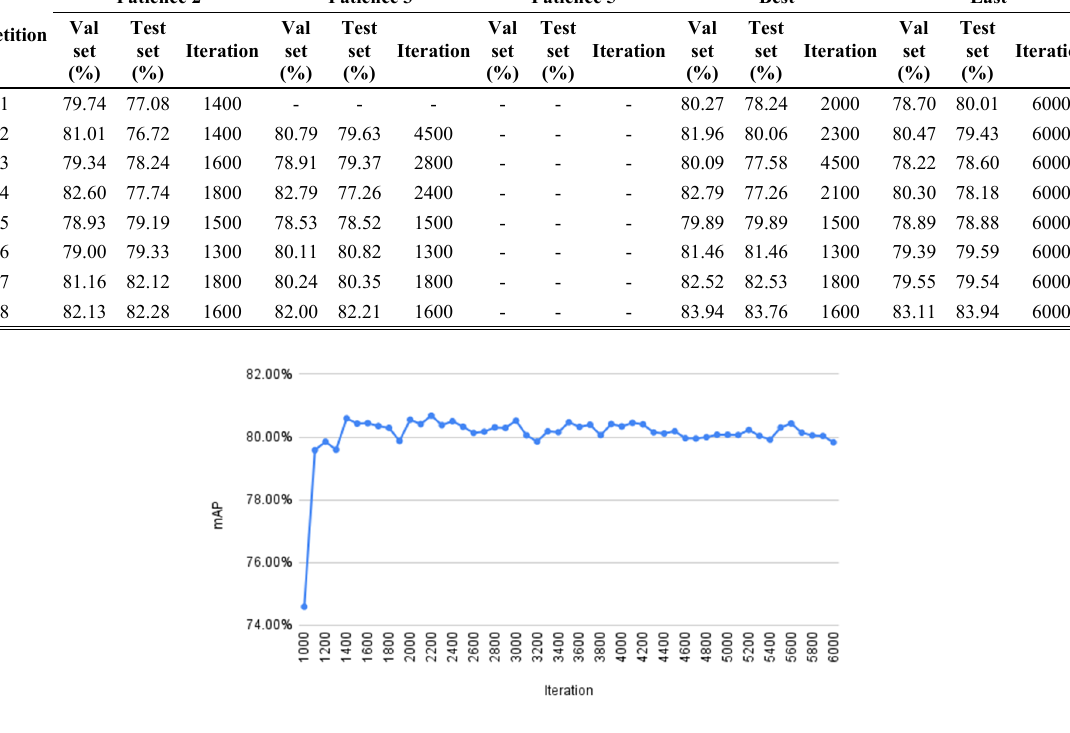
Fig. 4 Average mAP of all ball dataset experimental repetitions V.